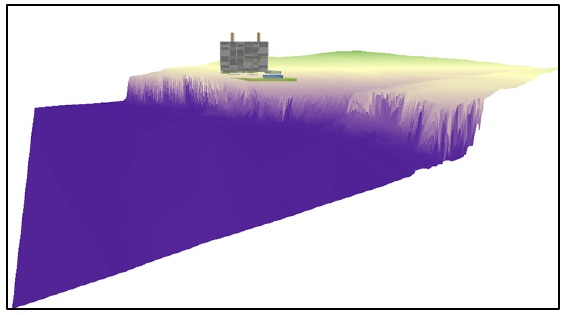
Figure 6: A shape that cannot be represented by 2D extrusion